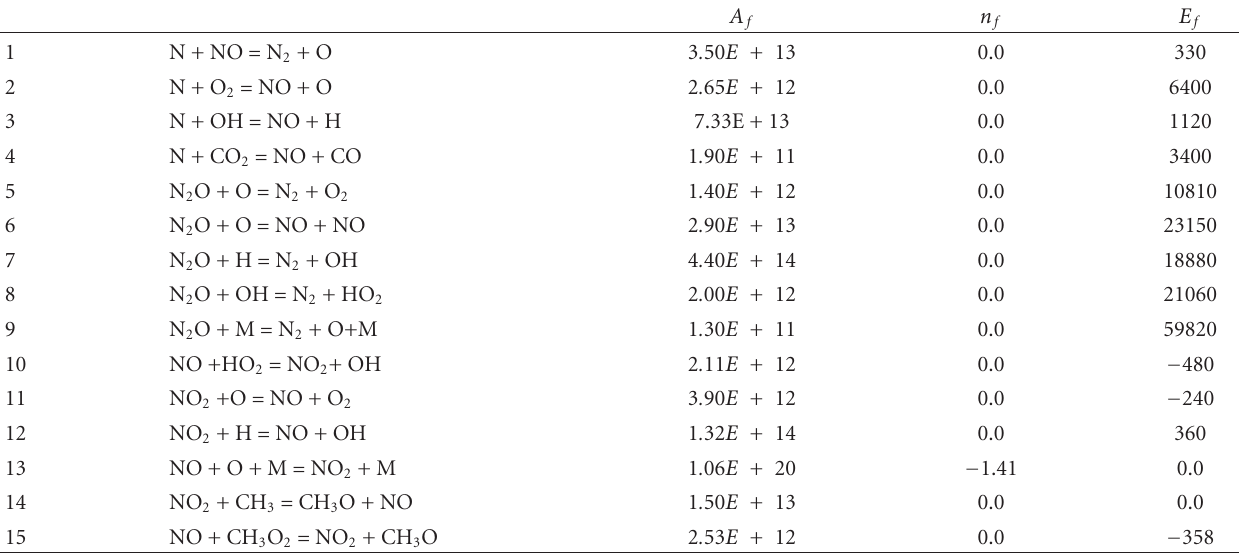
Table 1: Elementary steps in the thermal mechanism of NO and N 2 O. The forward reaction rate is given by k f = A f T n f exp( − E f /RT ) [12].